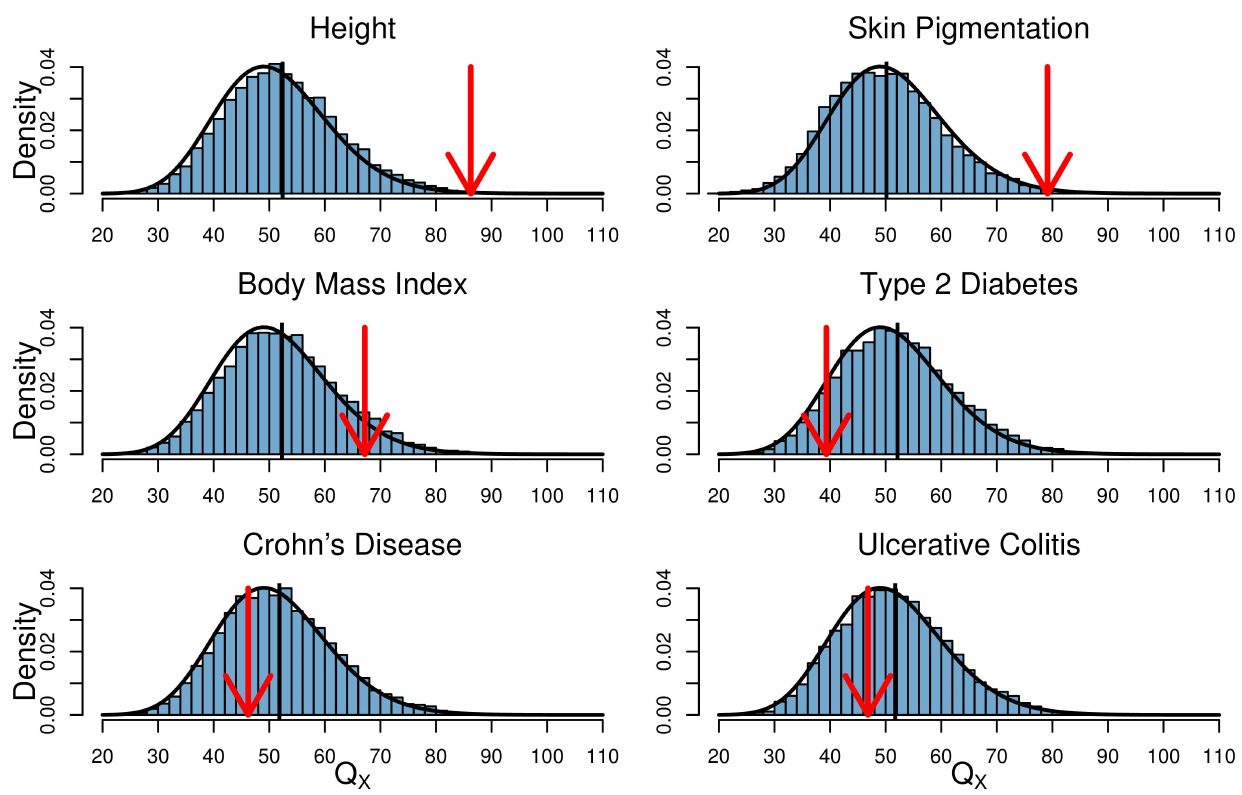
Figure 3. Histogram of the empirical null distribution of Q X for each trait, obtained from genome-wide resampling of well matched SNPs. The mean of each distribution is marked with a vertical black bar and the observed value is marked by a red arrow. The expected x 2 is shown as a black curve.